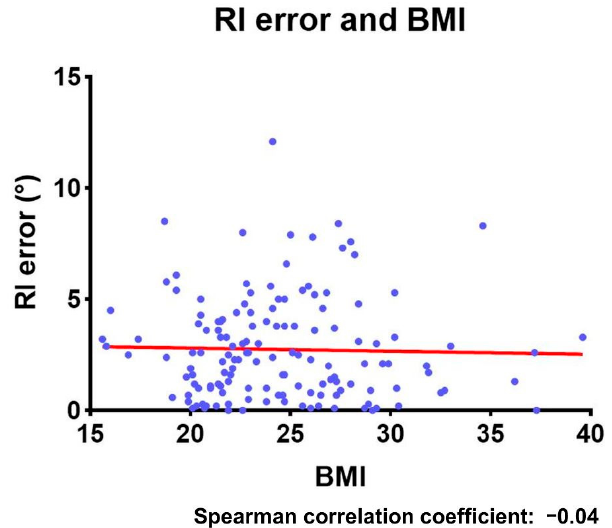
Figure 3. The relationship between the RI error and the patient’s BMI. RI: radiographic inclination; BMI: body mass index.